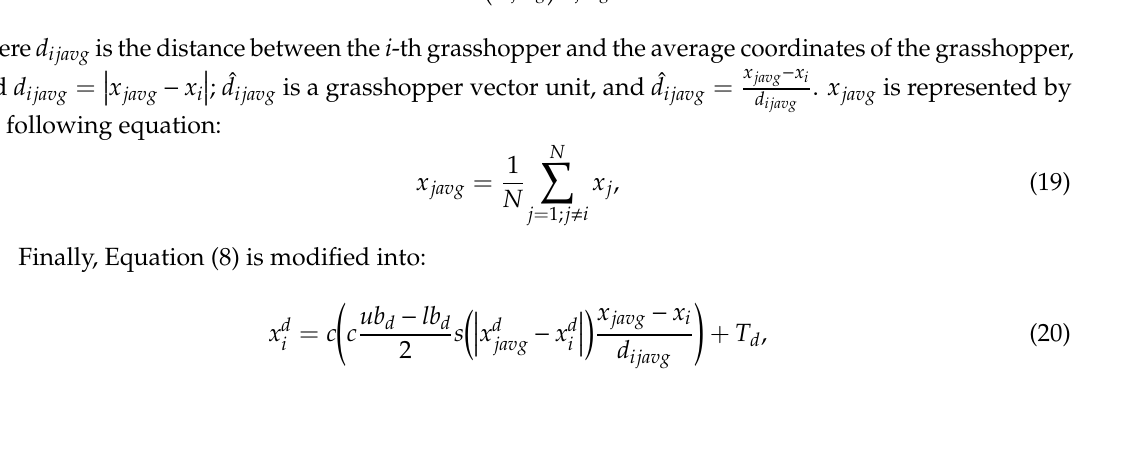
Figure 5. Calculation of i S in ECGOA arithmetic mean.